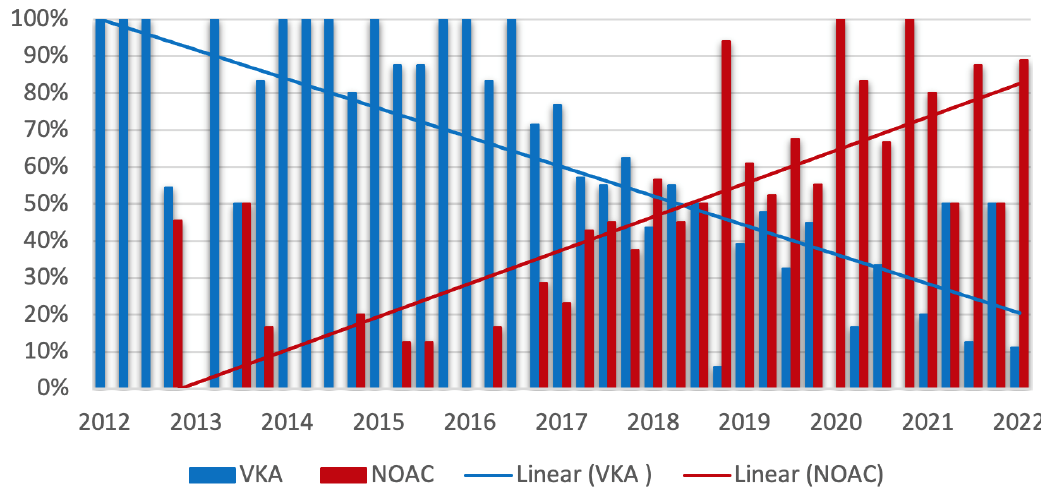
Figure 4. Trends in prescription of vitamin K antagonists (VKA) and nonvitamin k antagonist oral anticoagulants (NOAC) during the study period . Quarterly plot with linear trend line of prescription of VKA (blue) and NOAC (red). The percentages refer to all patients with indication for oral anticoagulation (449/609). Comparison of prescriptions in the first and second half of the study period: VKA: 72.9% vs. 35.6%, p < 0.0001; NOAC: 27.1% vs. 64.4%, p < 0.0001.